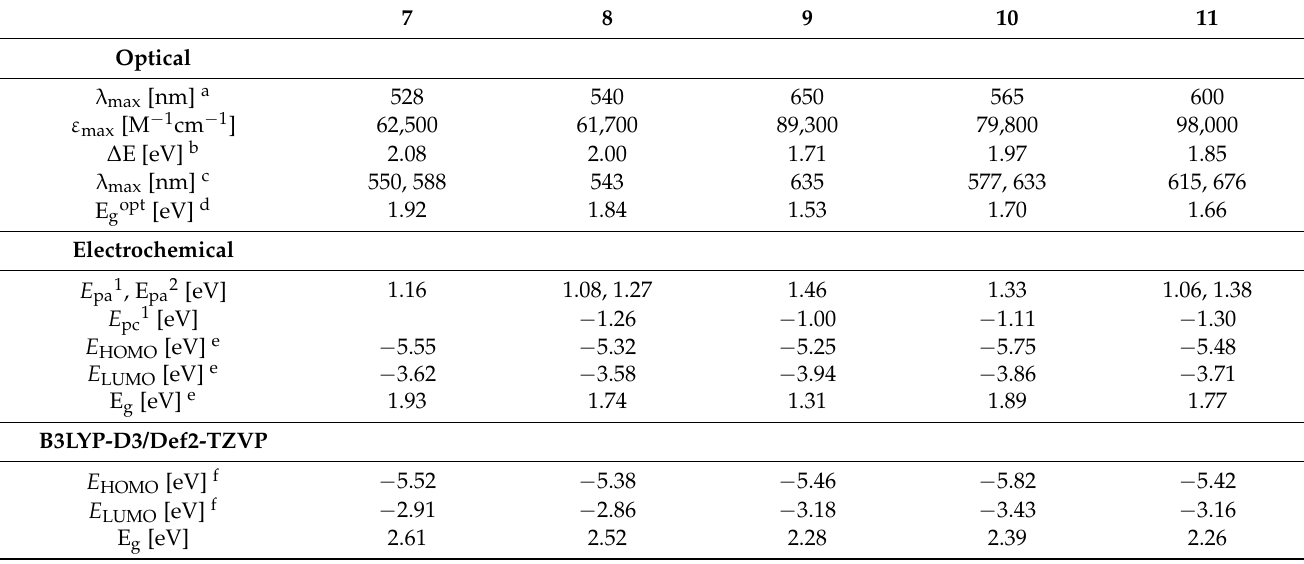
Table 1. Experimental and calculated optoelectronic properties of compounds 7 – 11.